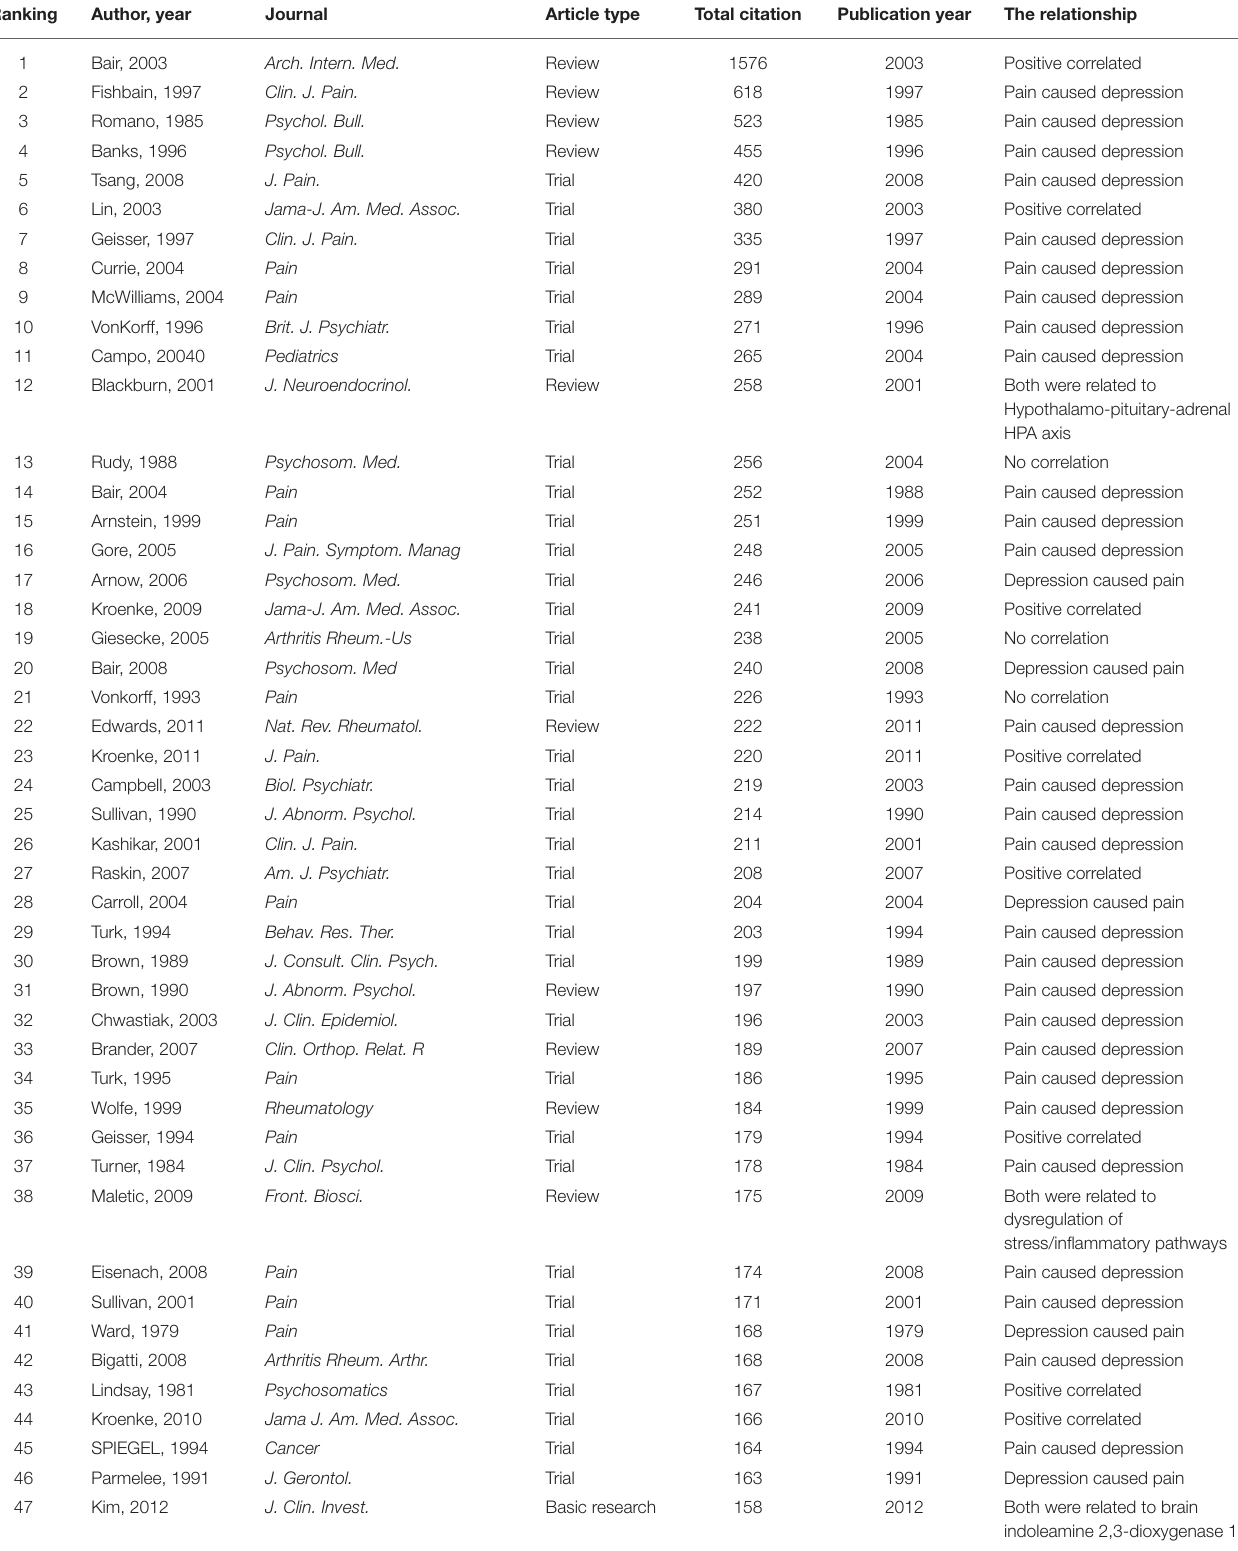
TABLE 1 | The 100 top-cited studies in pain and